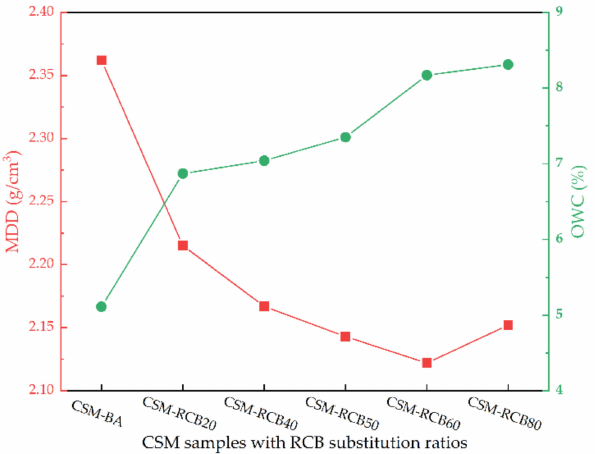
Figure 3. MDD and OWC results of CSM samples.